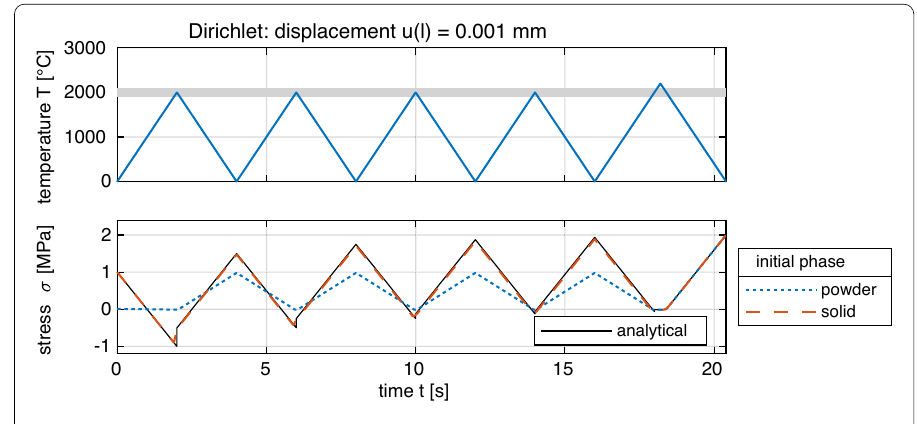
Fig. 5 Stress over time induced by a repeated partial melt and a final full melt. Inhomogeneous Dirichlet boundary conditions. Phase change interval in